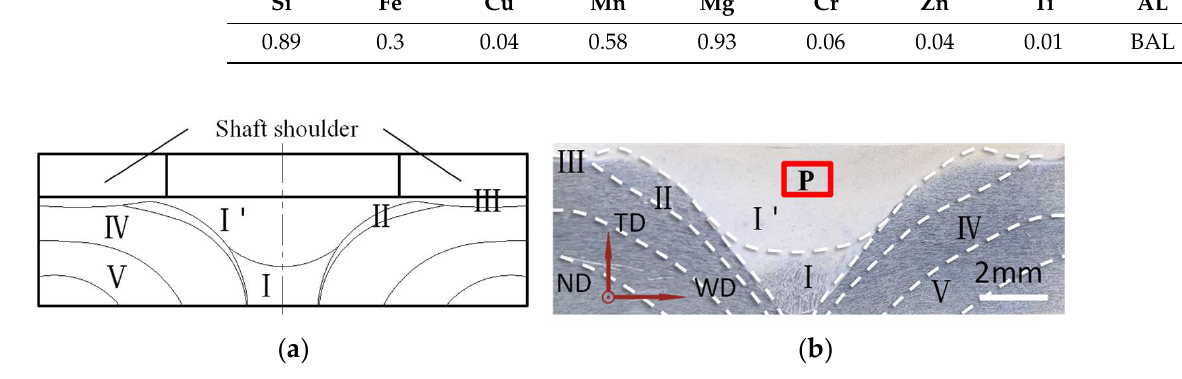
Figure 2. Diagram of a joint’s partition and morphology, and EBSD sampling location. ( a ) Diagram of a joint’s partition. ( b ) When the rotation speed of the plug is 1800 rpm.